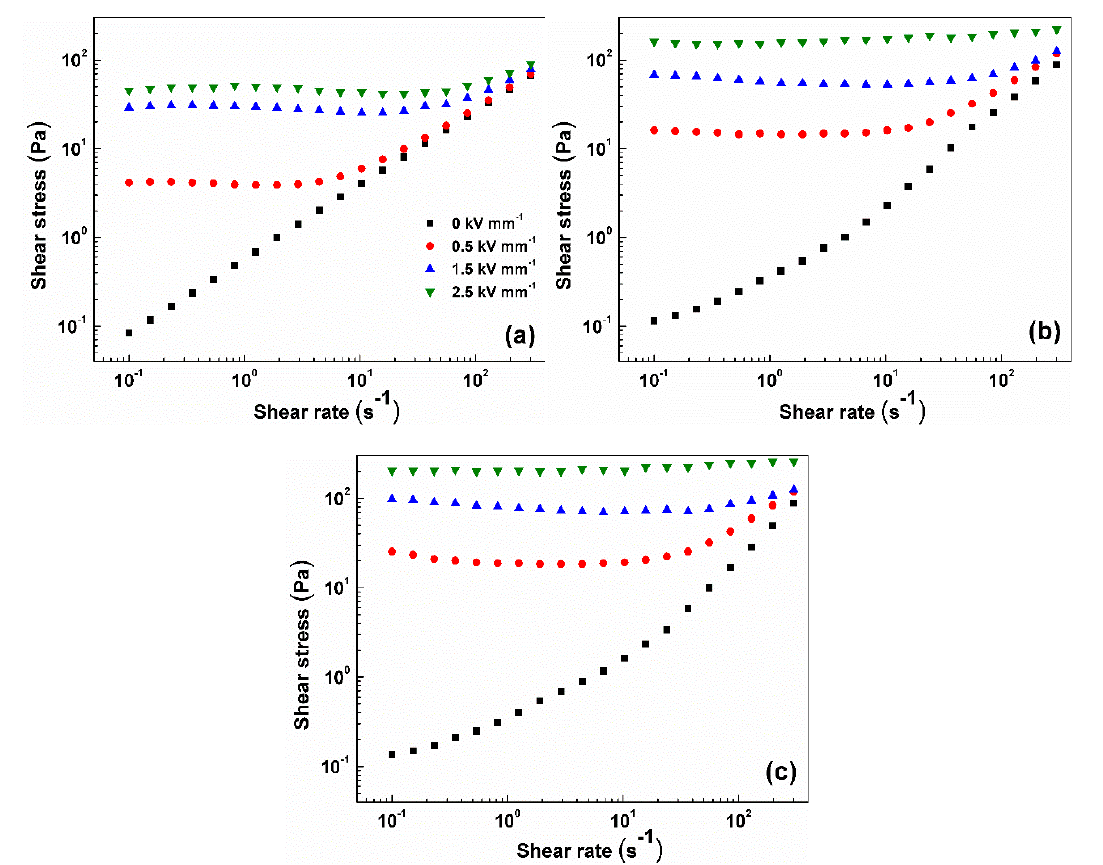
Figure 6. Dependence of the shear stress on the shear rate for 5 wt.% ER fluids consisting of original GO ( a ), GO-PHEMATMS-1 ( b ), and GO-PHEMATMS-2 ( c ) particles in silicone oil M200. The electric field strengths (kV·mm –1 ): 0 ( ), 0.5 ( ), 1.5 ( ), and 2.5 ( ).